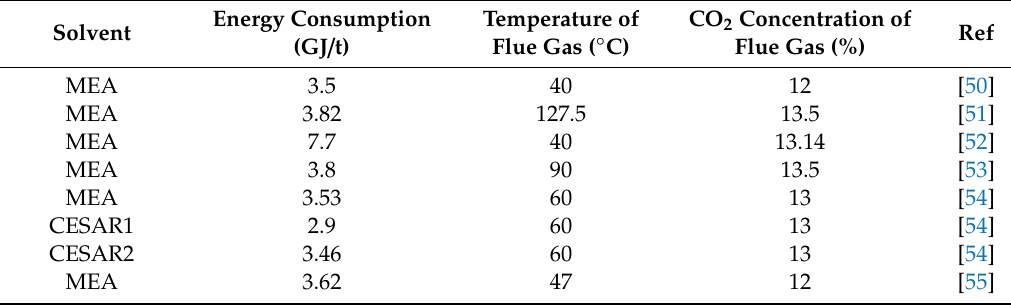
Table 2. Energy consumption data of large scales CCS